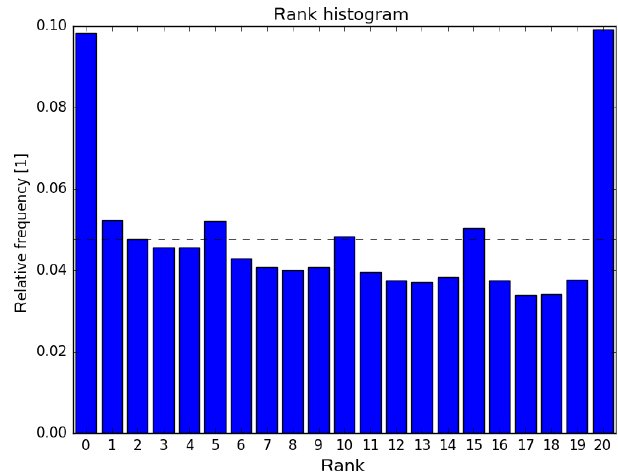
Figure 1. Rank/Talagrand histogram for 1-hourly precipitation amounts of COSMO-DE-EPS and forecast lead time 3h; data for 18 stations from 2011 to